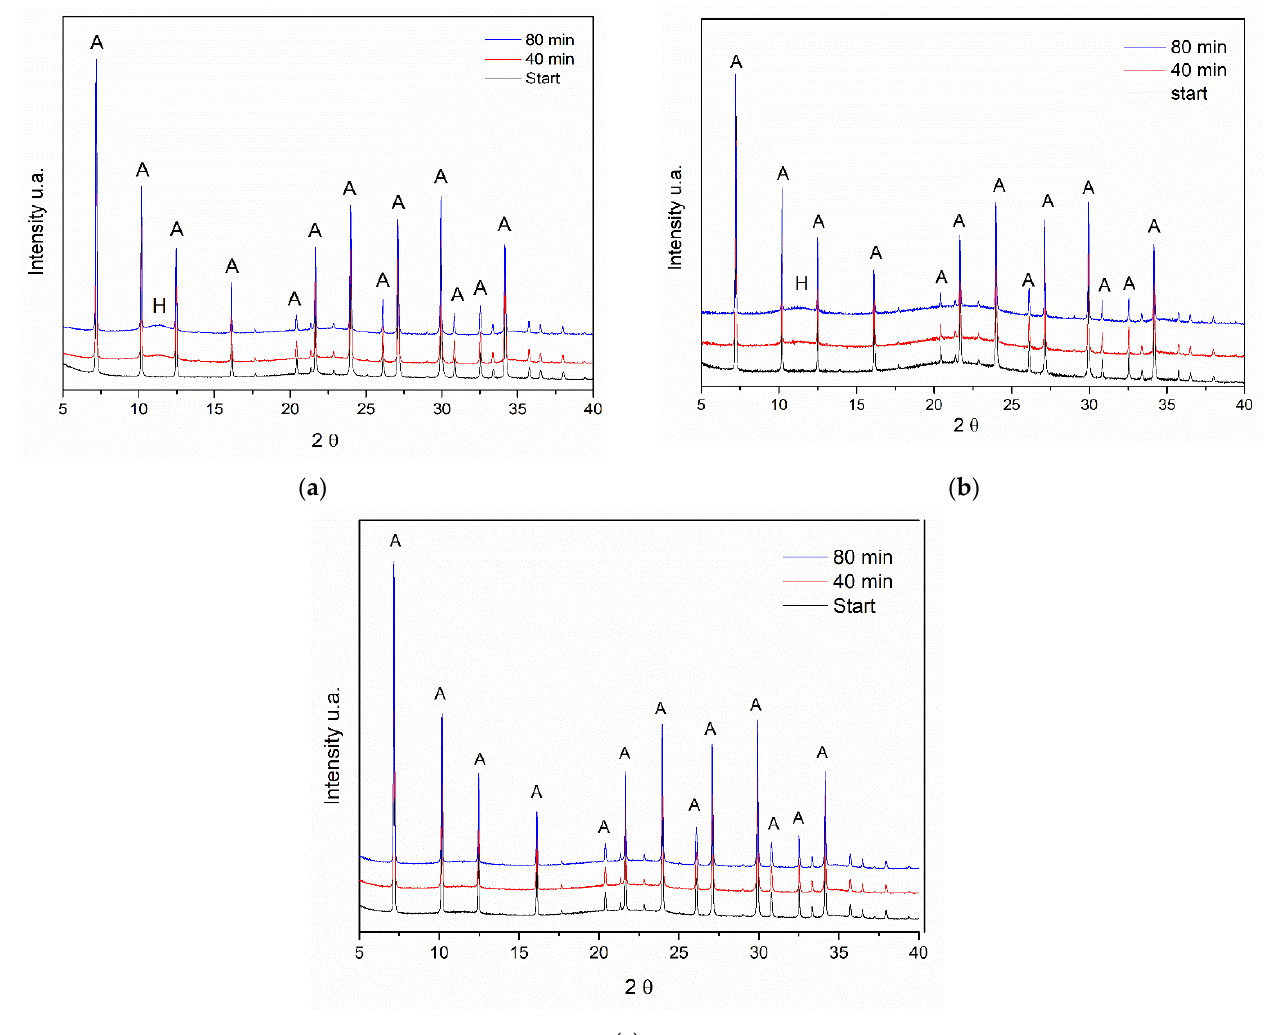
Figure 6. Diffractograms of the samples after rehydration in an atmosphere of H 2 O vapor at room temperature: ( a ) He flow at 300 °C, ( b ) O 2 flow at 300 °C, and ( c ) O 2 flow at 500 °C. The symbol (A) indicates the reflections belonging to the zeolite A phase and (H) indicates the reflections referring to the hydrotalcite phase. The plane (003) characteristic of the LDH phase is also indicated in in rehydrated sample.